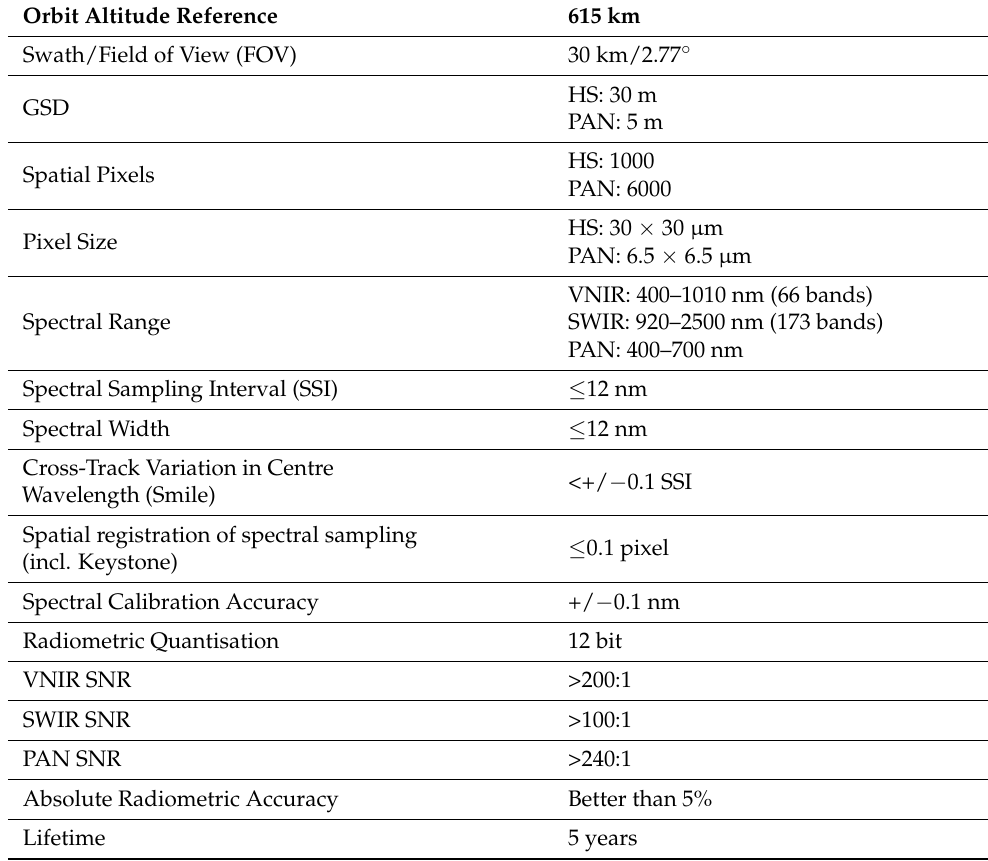
Table 2. PRISMA’s technical